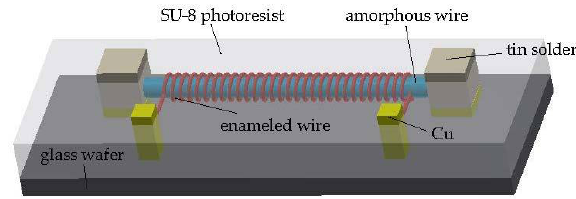
Figure 1. Design of the amorphous alloy wire magnetic sensor.